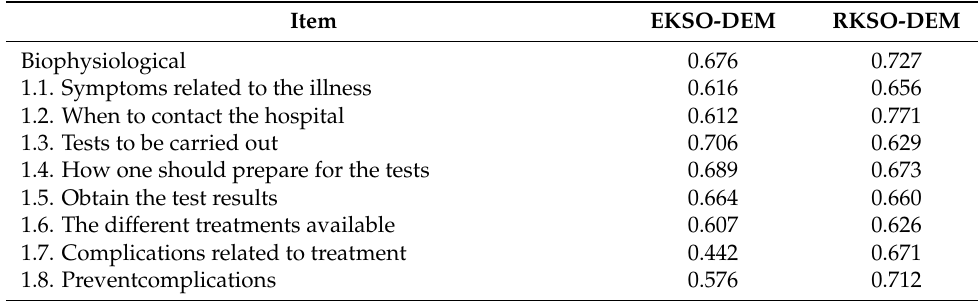
Table 6. Test–retest temporal stability (reproducibility). All items have temporal stability (intraclass correlation coefficient p value lower than